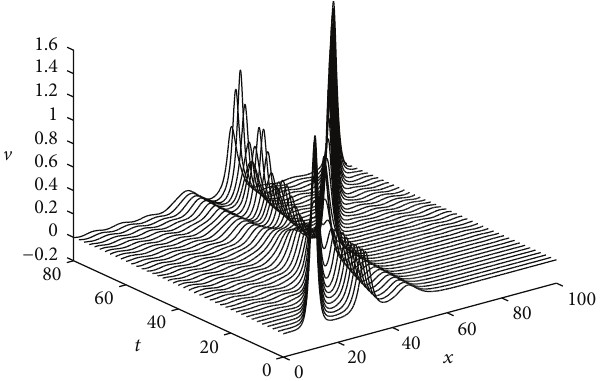
Figure 9: Interaction of three solitons: numerical solution 𝑉 𝑛 with parameters 𝜆 1 = 1 , 𝜆 2 = 0.6 , and 𝜆 3 = 0.3 .